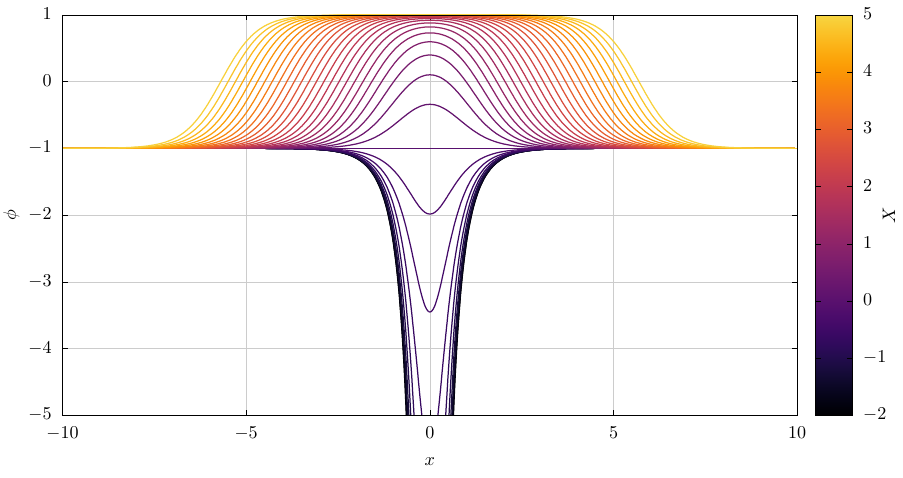
Figure 6 . BPS solutions for di(cid:11)erent values of the moduli parameter X for the annihilating impurity with j =